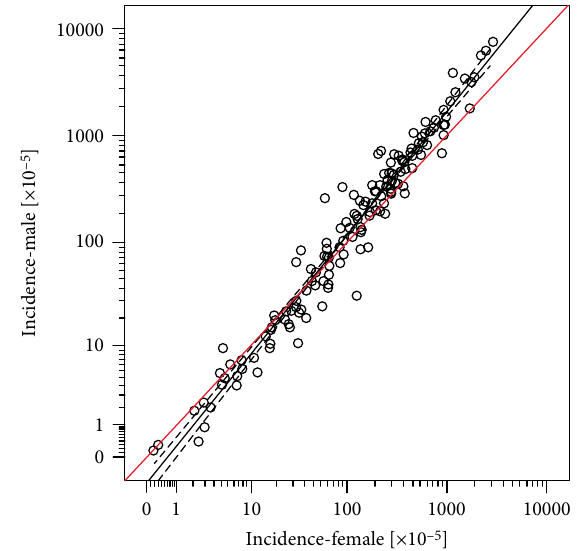
Figure 2: Age-specific BCC incidence rates (cases/100,000 population) of males as a function of the “twin” female data (same age range, same data set). Black line: best fit regression line ( 𝑟 2 = 0.980 ; dashed lines: 95% confidence intervals of predicted value). Red line: line of equal incidence rates of the two sexes (slope: 𝑏 󸀠 = 1.000